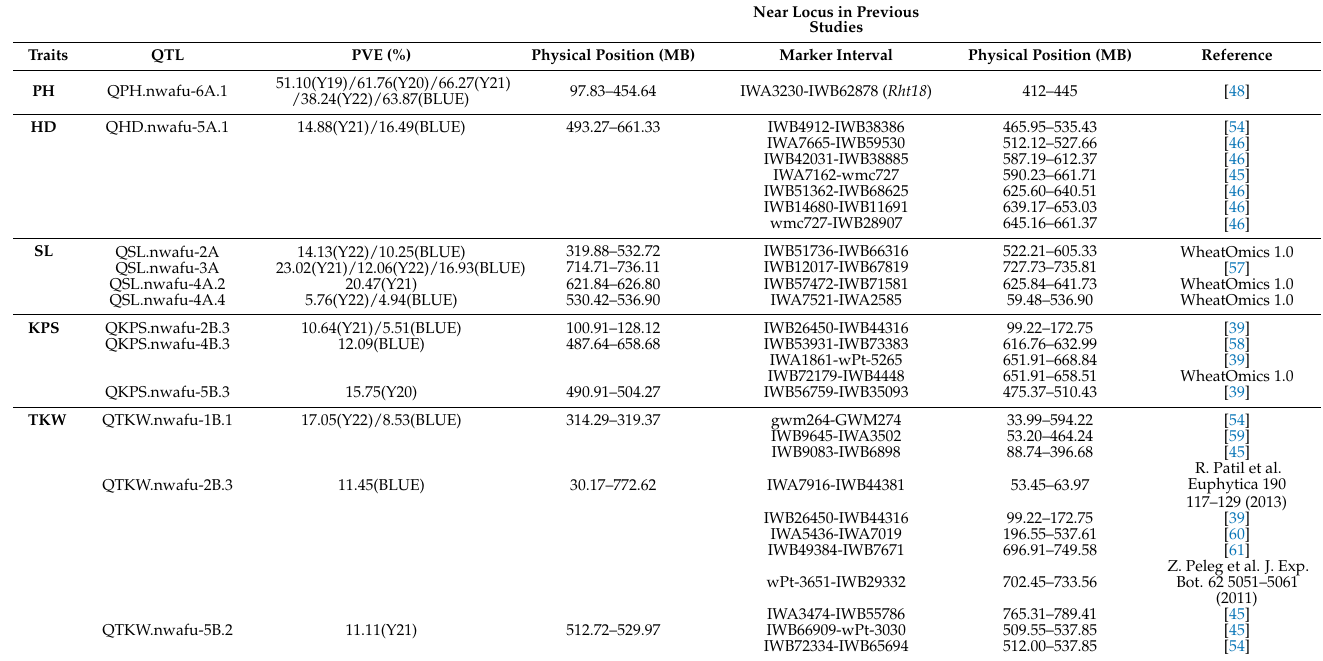
Table 5. QTL mapped in this study compared with those previously